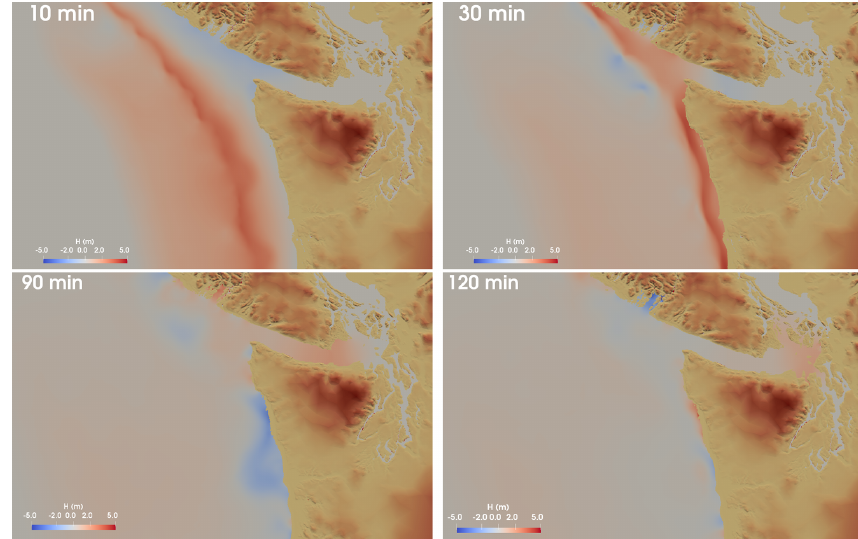
Figure 7. Snapshots of the tsunami propagation of scenario 24 at time intervals T = 10, 30, 90 and 120min.